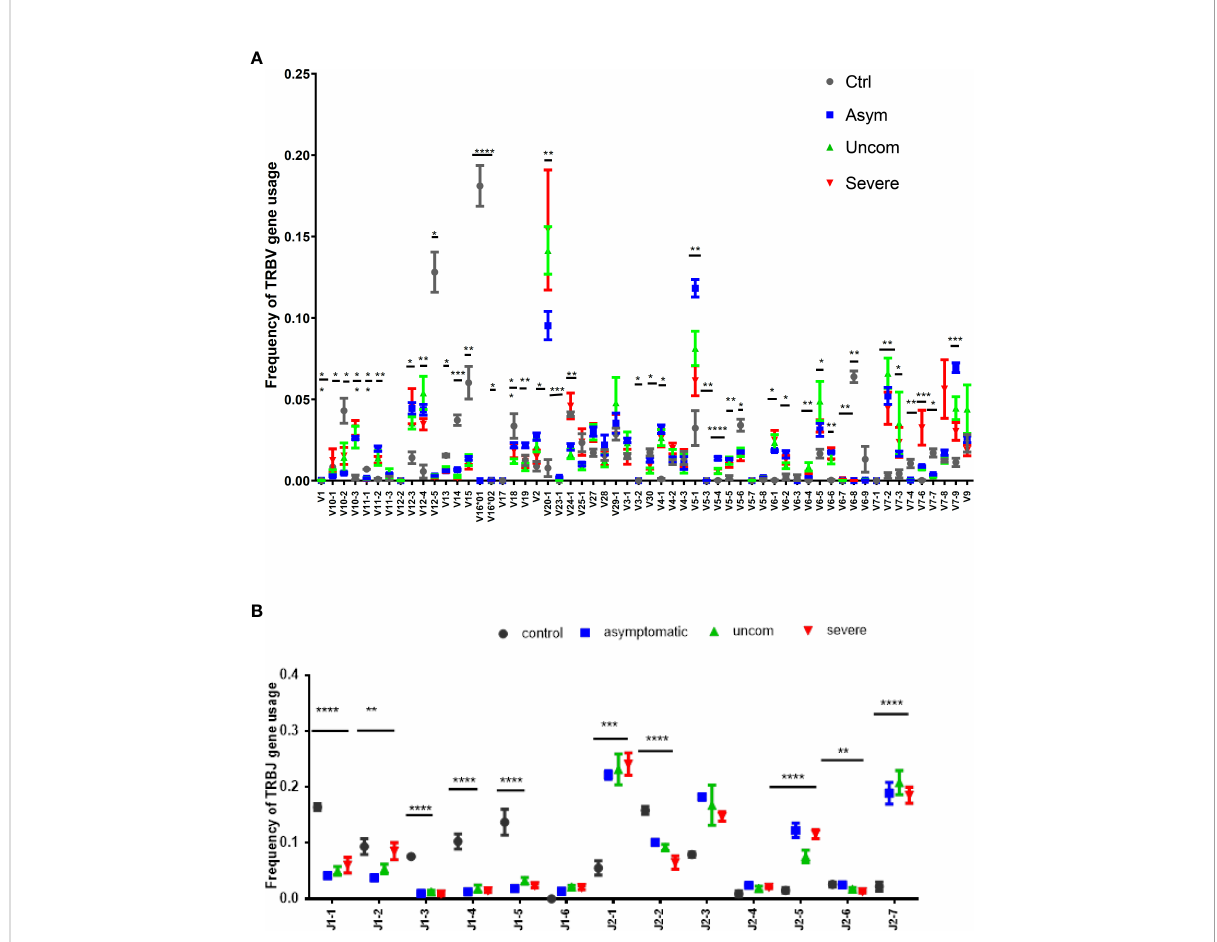
FIGURE 2 Pattern of V b and J b gene usage. The data show the frequency of (A) V b and (B) J b gene usage among the study population; controls (n=4), asymptomatic (n=7), uncomplicated (n=9) and severe malaria (n=8). The plots show the mean proportions with the standard error. The asterisks (*) show the signi fi cant difference in the gene usage; ****p<0.0001, ***p<0.001, **p<0.01, *p<0.05. One-way ANOVA was used for comparisons followed by Holm Sidak ’ s correction for multiple